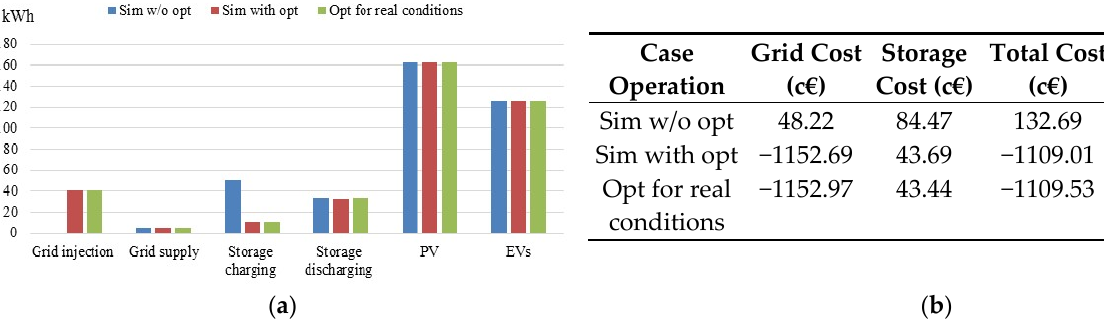
Figure 8. ( a ) Energy system distribution and ( b ) energy system cost—case 1.